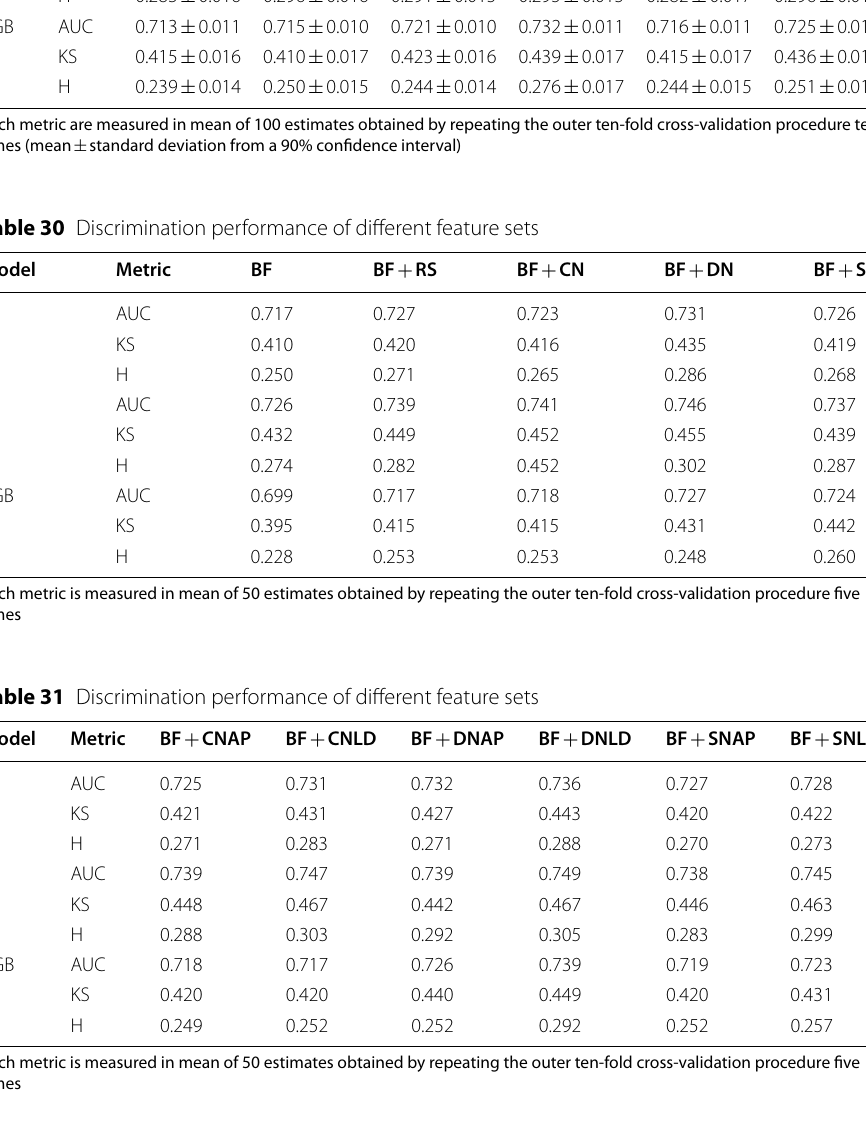
Each metric is measured in mean of 50 estimates obtained by repeating the outer ten-fold cross-validation procedure five times